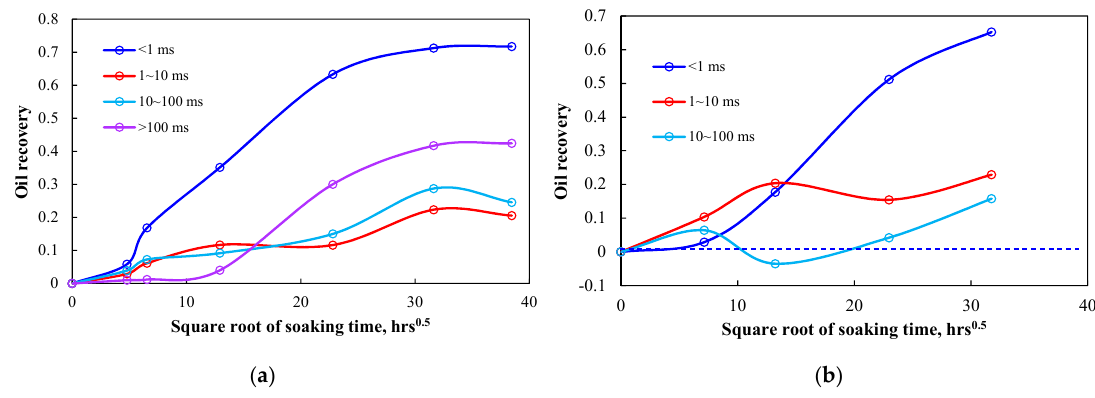
Figure 5. Oil recovery in different diameter pores: ( a ) UC7-1 and ( b ) LC7-1. Figure 4. The T 2 spectra vs soaking time in UC7-1 and LC7-1 samples: ( a ) UC7-1 and ( b ) LC7-1.